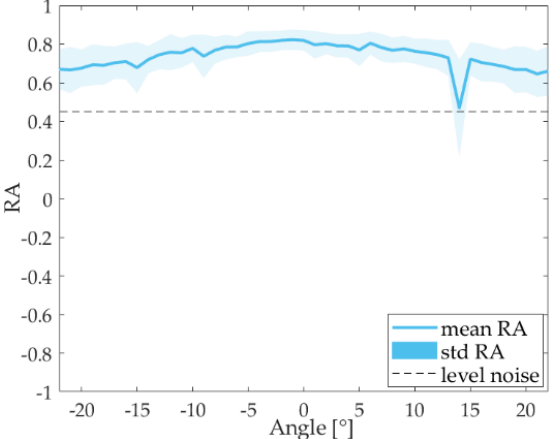
Figure 5. Relative amplitude for string bits.